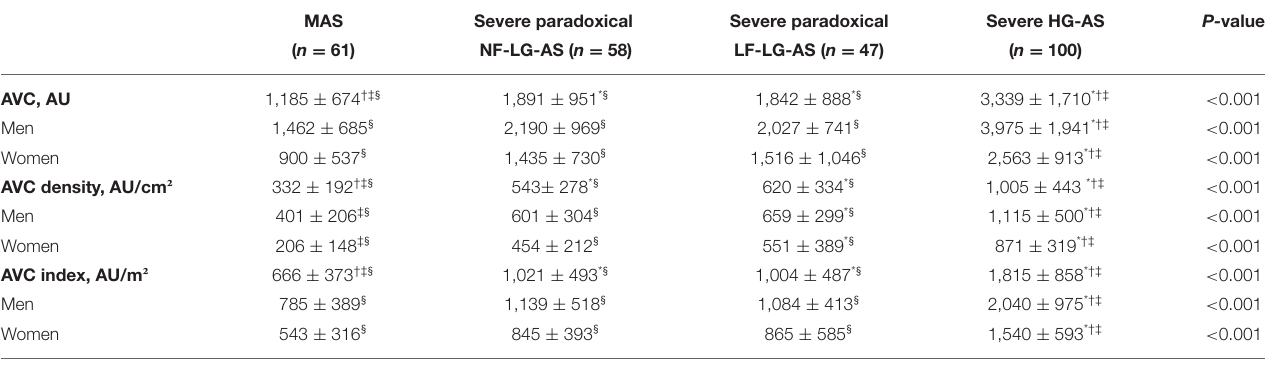
TABLE 3 | AVC load in patients with moderate AS, severe paradoxical LG-AS and severe HG-AS. MAS Severe paradoxical Severe